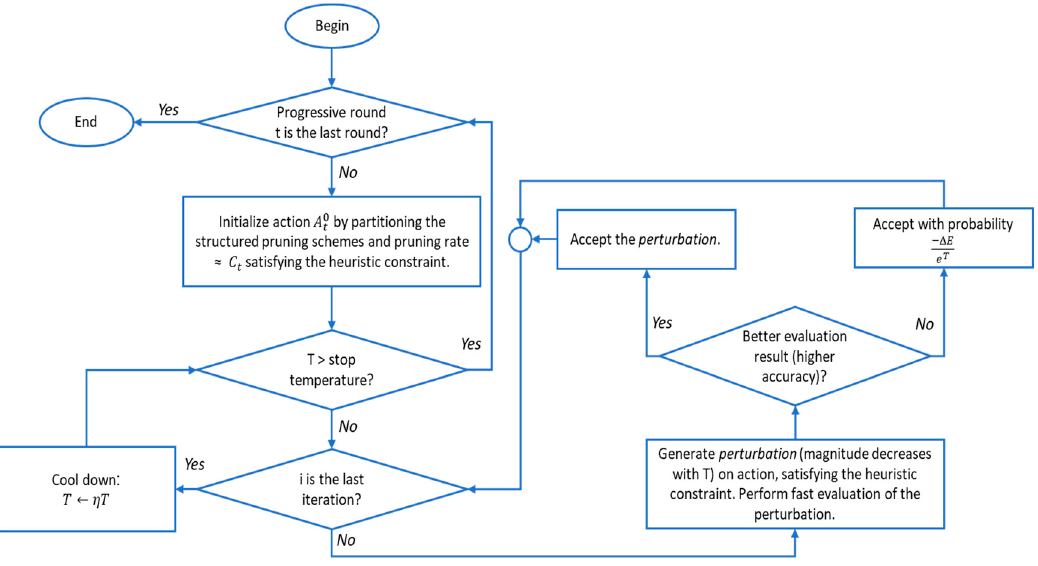
Figure 3. Flowchart of auto-compression algorithm.